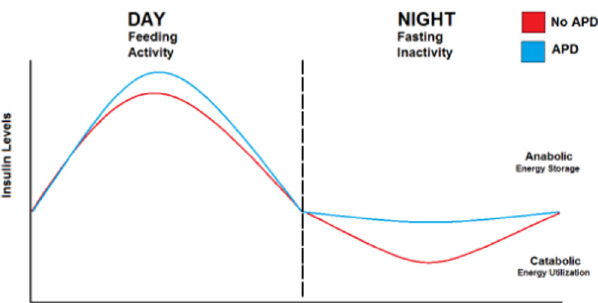
Fig. 4 Model for antipsychotic drug disruption of circadian rhythms in insulin secretion. Insulin secretion follows a diurnal pattern with peaks during the day and lowest levels at night, corresponding to metabolic demands, periods of fasting and feeding behaviors in humans. By blocking dopamine D 2 and D 3 receptors, antipsychotic drugs ( APDs ) decrease the ability of dopamine receptors to negatively regulate insulin levels, raising overall insulin levels. At night time, during periods where catabolic states